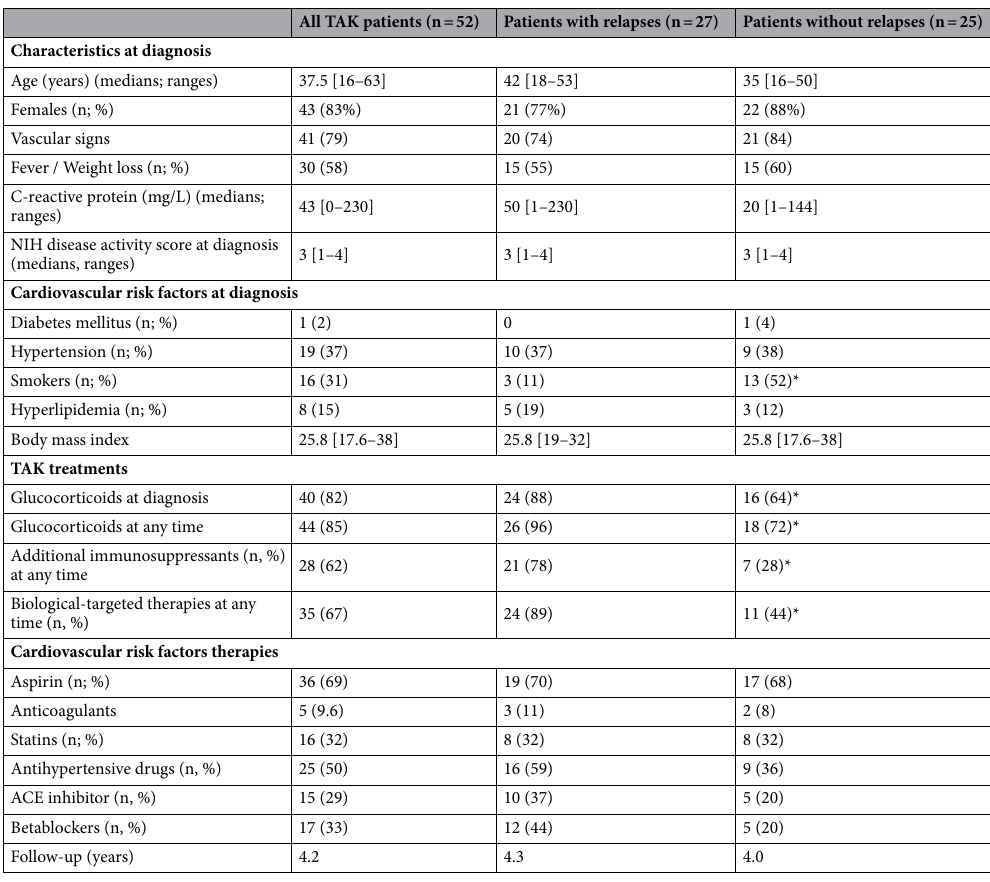
Table 2. Comparison of Takayasu arteritis (TAK) patients with and without relapse during the follow-up. Values are medians with ranges and numbers with frequencies. * p < 0.05.